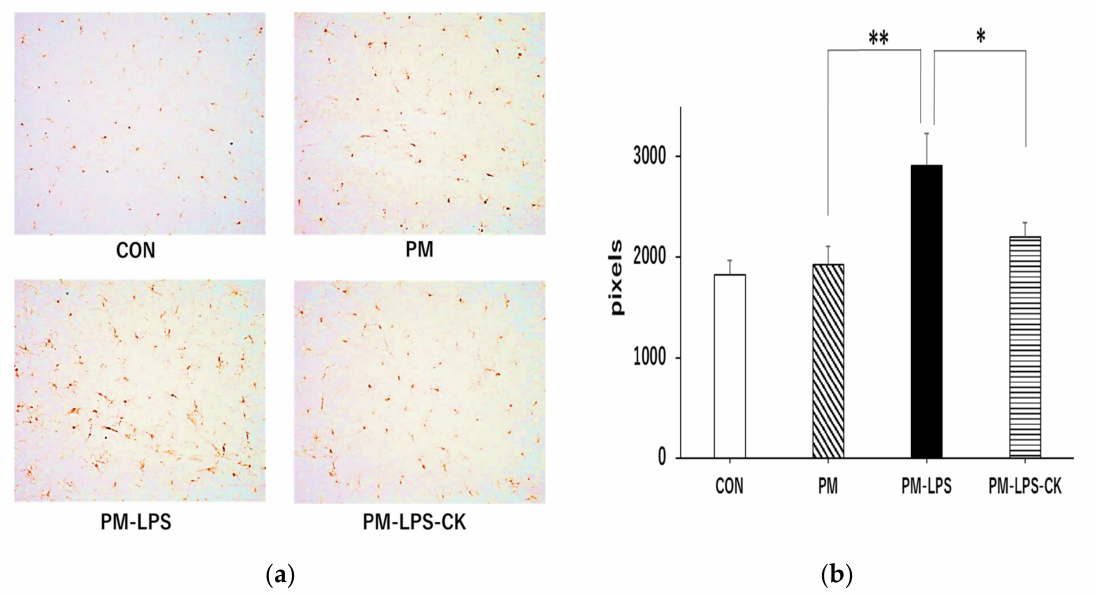
Figure 5. Effects of dried C. kawachiensis peel powder on microglial activity in the hippocampus of the 2-day group. ( a ) Representative microglia pictures stained with anti-Iba1 antibody. ( b ) Quantitative analysis of the area of Iba1-positive signals using ImageJ software. Values are means ± SEM. Symbols show significant differences for the following conditions: PM vs. PM–LPS (** p < 0.01), and PM–LPS vs. PM–LPS–CK (* p < 0.05). The number of samples in each group is as follows: CON: n = 23, PM: n = 23, PM–LPS: n = 23, PM–LPS–CK: n =